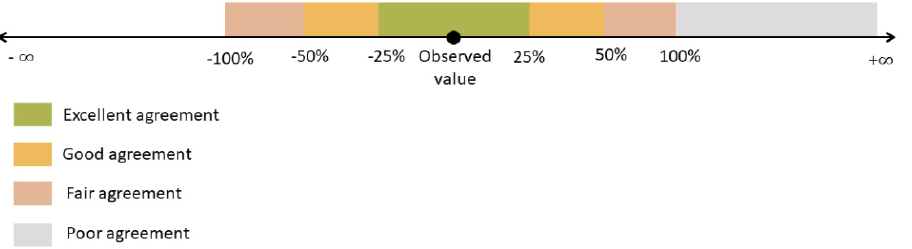
Figure 6. Level of agreement between modeled and observed parameters based on the relative percent error.